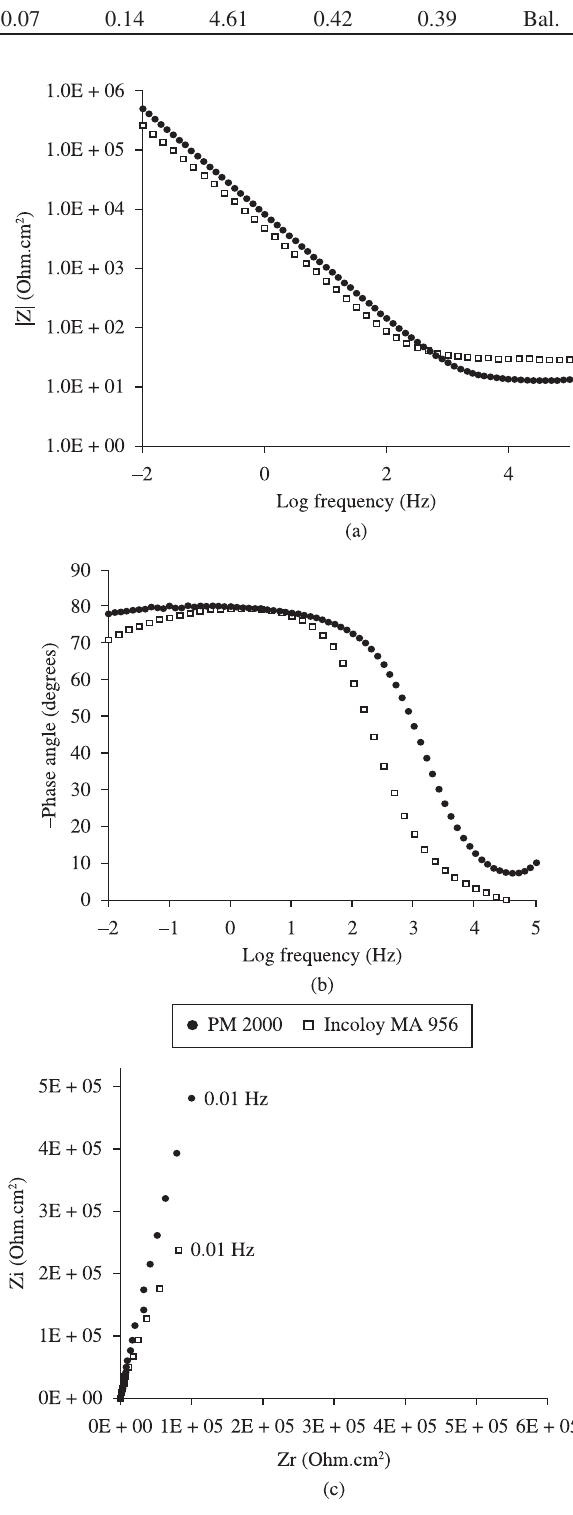
Figure 1. EIS diagrams obtained for the Incoloy MA 956 and the PM 2000 after 48 hours of immersion in PBS at 25 °C. a) Z modulus; b) phase angle; and c) Nyquist